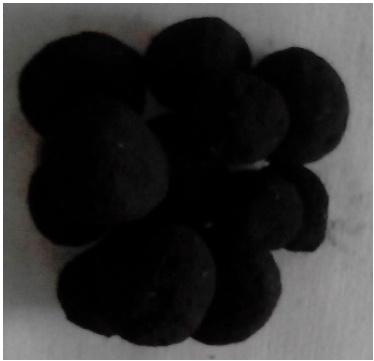
Figure 5. Shape of homemade regular Fe/C/Al multiple micro-electrolysis filler.